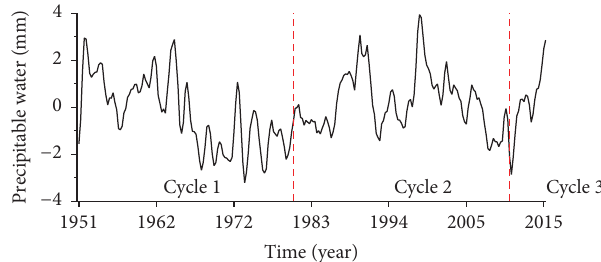
Figure 8: Time series of PW excluding the trend features after seasonal adjustments and smoothness procedures were applied (calculated with season as the basic unit).